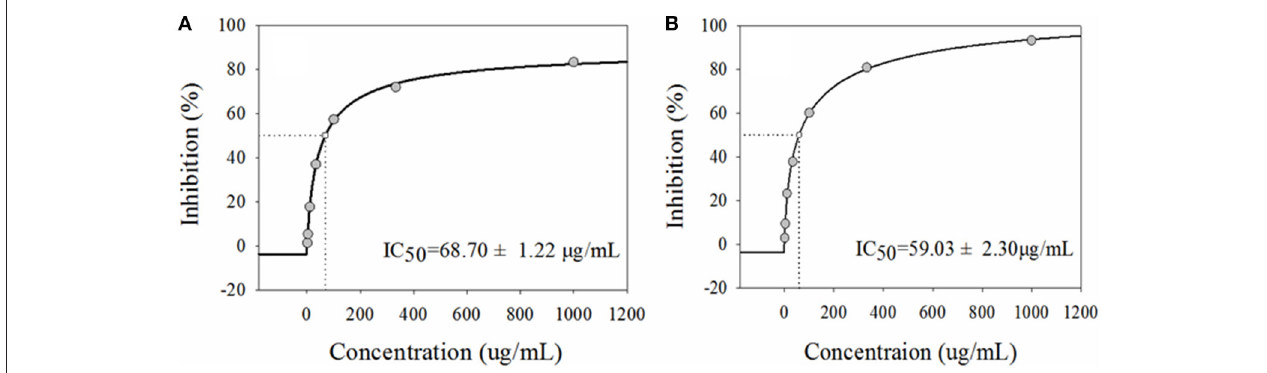
FIGURE 1 | The half-maximal inhibitory concentrations (IC 50 ) of the extract from G. sylvestre (A) and acarbose (B) on α -glucosidase in vitro . They exhibited comparable dose-dependent manners with the IC 50 at 68.70 ± 1.22 and 68.70 ± 1.22 µ g/mL, respectively.